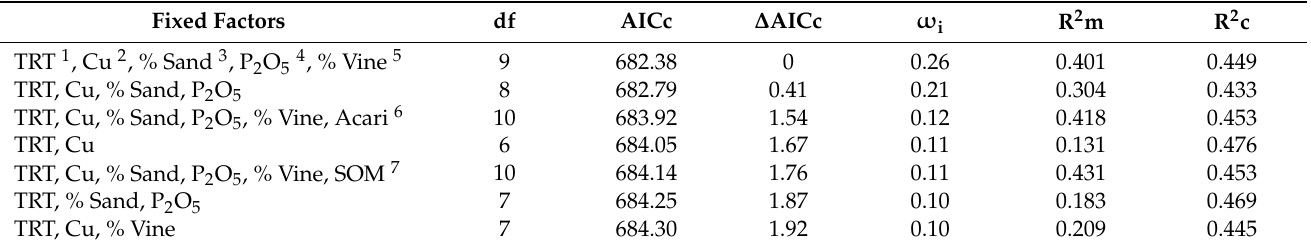
Table 1. Candidate models for carabid activity density used for model averaging, where df repre- sents the degrees of freedom used, AICc the second order Akaike Information Criterion, ∆ AICc the difference between AICc to the most parsimonious model, ω i the Akaike’s weight within the candidate models, R 2 m as the marginal R 2 value and R 2 c as the conditional R 2 value. Vineyard sites are used as random factors in all models